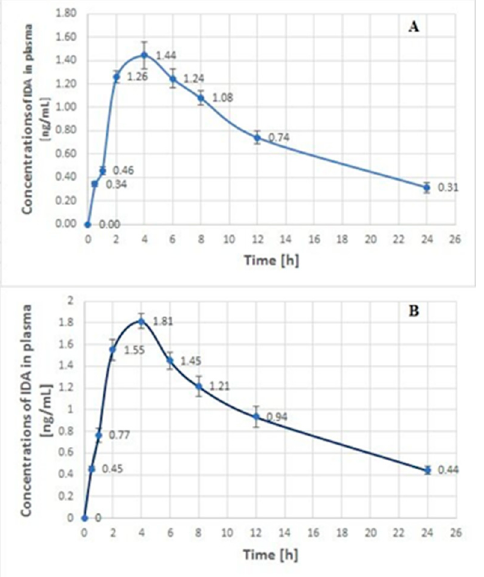
Figure 2. The concentration-time profiles of IDA in plasma samples (mean ± SD, n = 3) from a 17-year-old child with RMA after oral administration of IDA, each at a dose of 10 mg, on the 1st day ( A ) and the 10th day ( B ) of the O-TIDA/O-TE therapy, according to the CWS-2006 protocol.